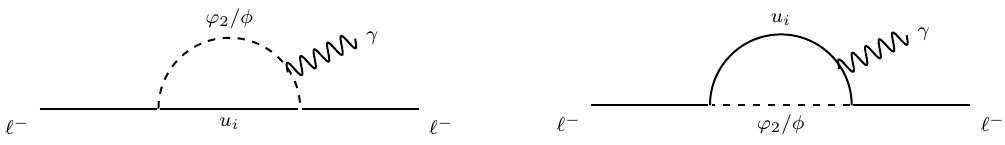
Figure 5. Dominant contributions to the lepton magnetic moment from BSM content in this model. Fermion lines are omitted as there are multiple valid assignments possible for these topologies, each of which will be considered in